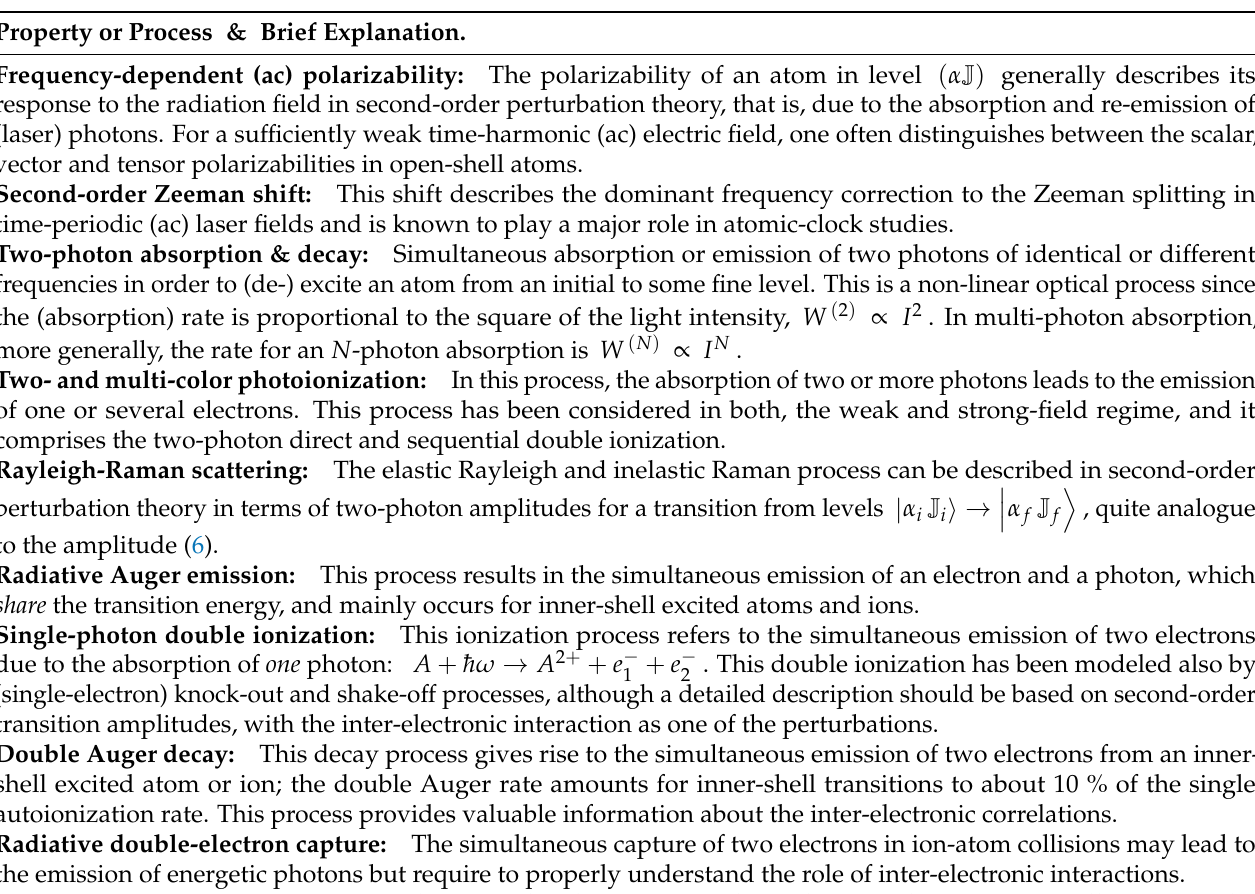
Table 4. Selected (second-order) properties and atomic processes that require a summation over one or several many-electron continua, i.e., a simple access to a proper representation of Green function channels. Property or Process & Brief